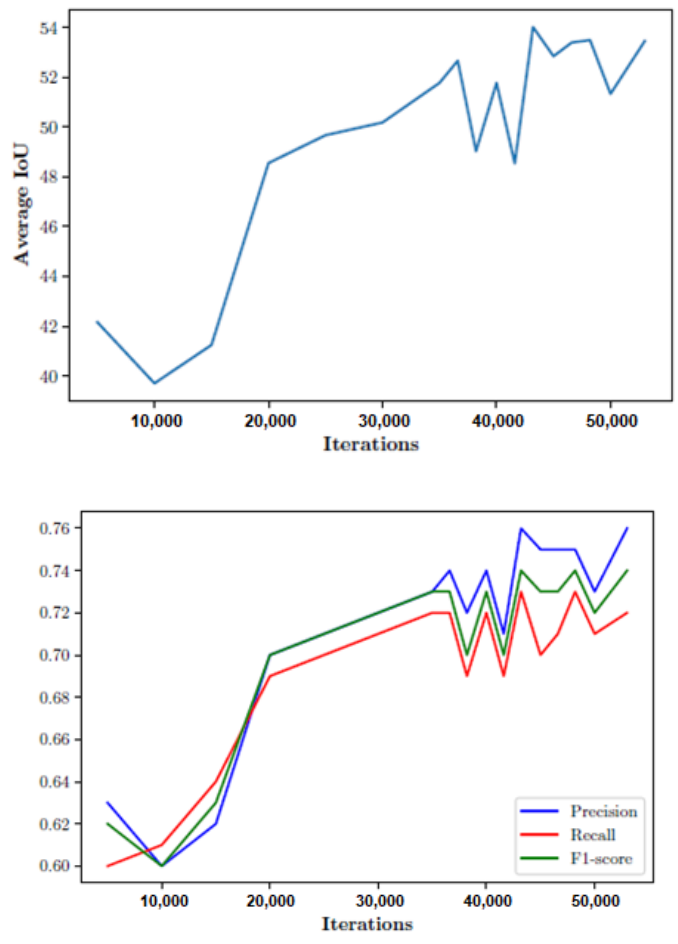
Figure 32. ( Top ) Average IoU and precision ( bottom ).